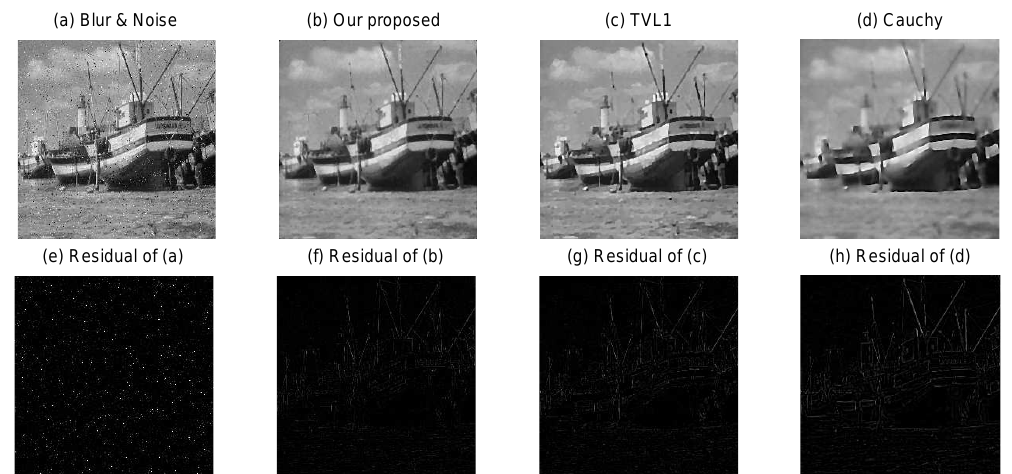
Figure 5. Recovered Phantom images from different methods.